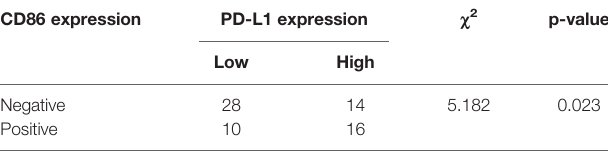
TABLE 2 | Chi-square test for evaluation of the relationship of CD86 and PD-L1 based on immunohistochemistry staining. CD86